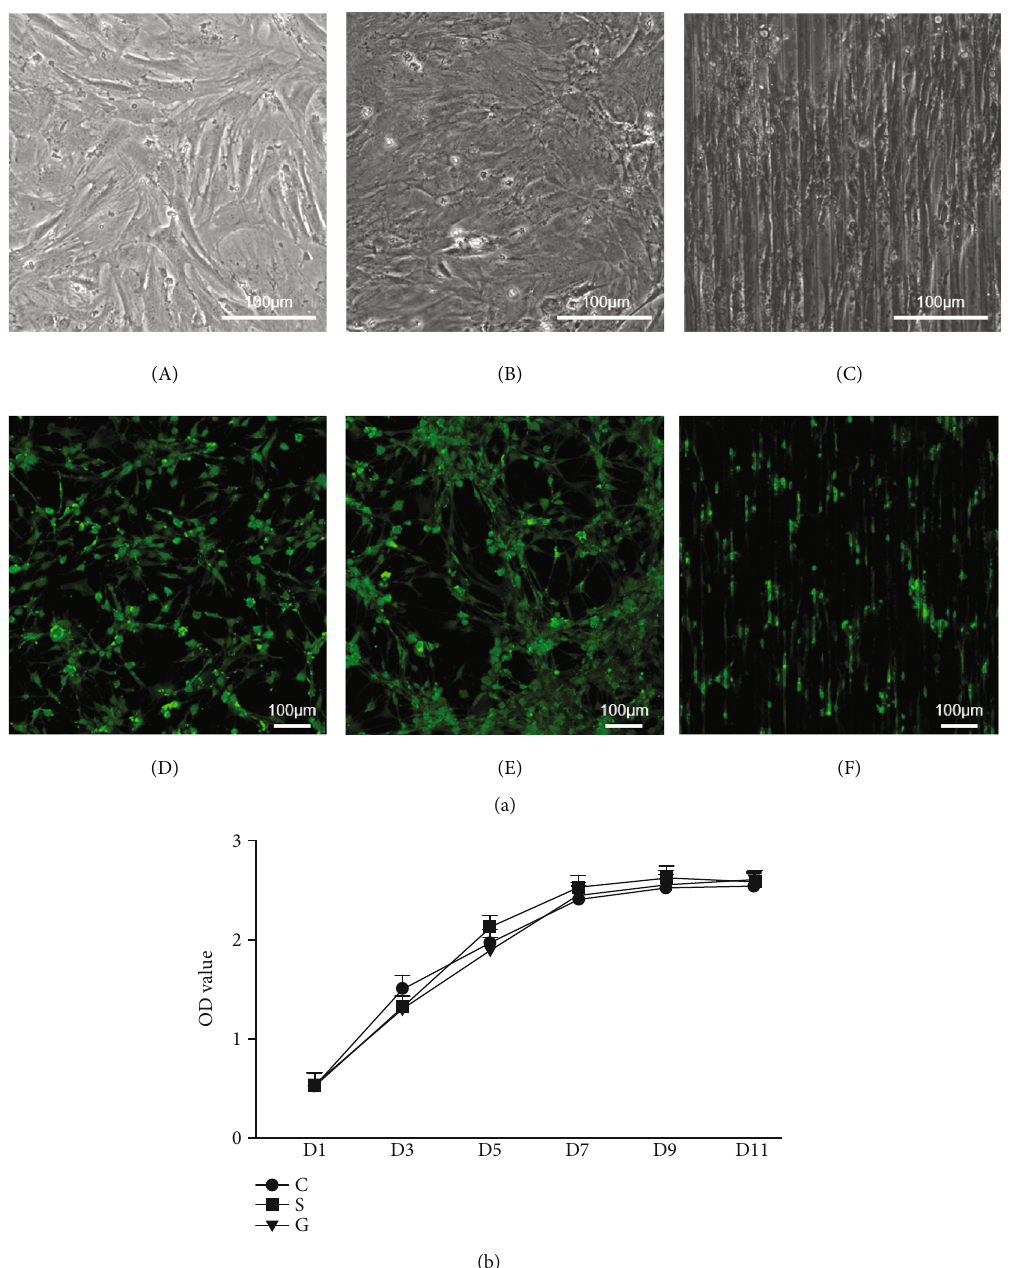
Figure 4: Live/dead cell staining and CCK-8 assay. (a) (A – C) Optical photomicrographs after TSPCs reached 90-100% con fl uence; (D – F) live/dead staining of TSPCs on the tissue culture plate (D), SF fi lm with a smooth surface (E), and SF fi lm with microstructure (F). (b) The CCK-8 curve of the di ff erent groups; group C: TSPCs on the cell culture plate; group S: TSPCs on the smooth SF fi lm; group G: TSPCs on the SF fi lm with a